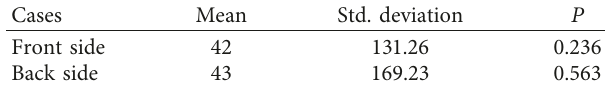
Table 2: Questionnaire dimensions and items.